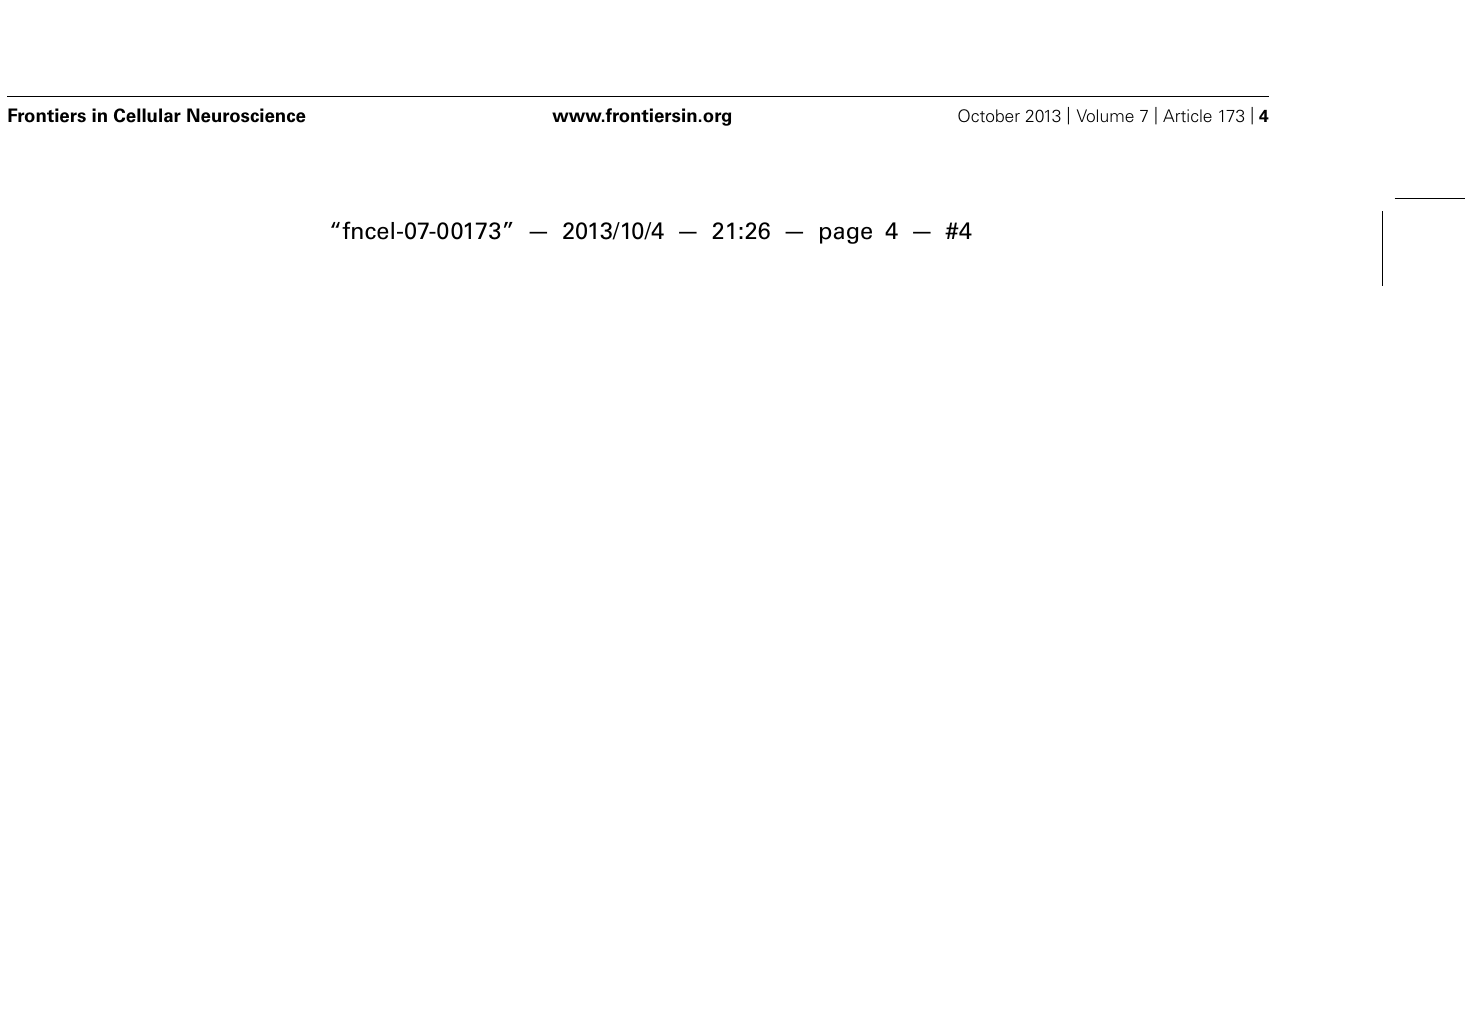
FIGURE 2 | Feed-forward effects of OFQ/N on the hypothalamic- pituitary-adrenal (HPA) axis response to stress. The stimulatory effects of OFQ/N on the HPA axis are mediated through disinhibitory signaling (*) in multiple brain regions. Following activation of the HPA axis, CORT is released into circulation. At the level of the hippocampus, CORT binds to and stimulates GR which provides negative feedback control over HPA axis activity (red solid arrows). Binding of CORT to GR also induces the expression of OFQ/N, which binds to NOPr in the hippocampus and inhibits glutamatergic transmission (blue solid arrows) thereby removing trans-synaptic inhibition of the PVN. Nociceptin signaling also inhibits